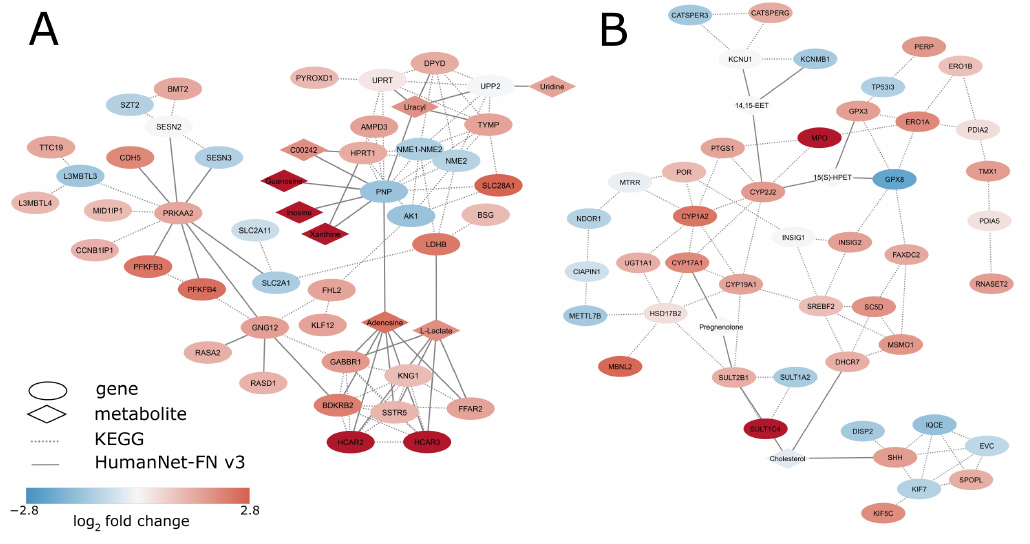
Figure 5. Results of de novo network enrichment analysis: Subnetworks enriched with genes, proteins, and metabolites perturbed in TOMM34 KO cells compared to WT cells. ( A ) Subnetwork #18 , related to purine and pyrimidine metabolism. ( B ) Subnetwork #41 , related to biotransformation, including oxidation by cytochrome P450 .